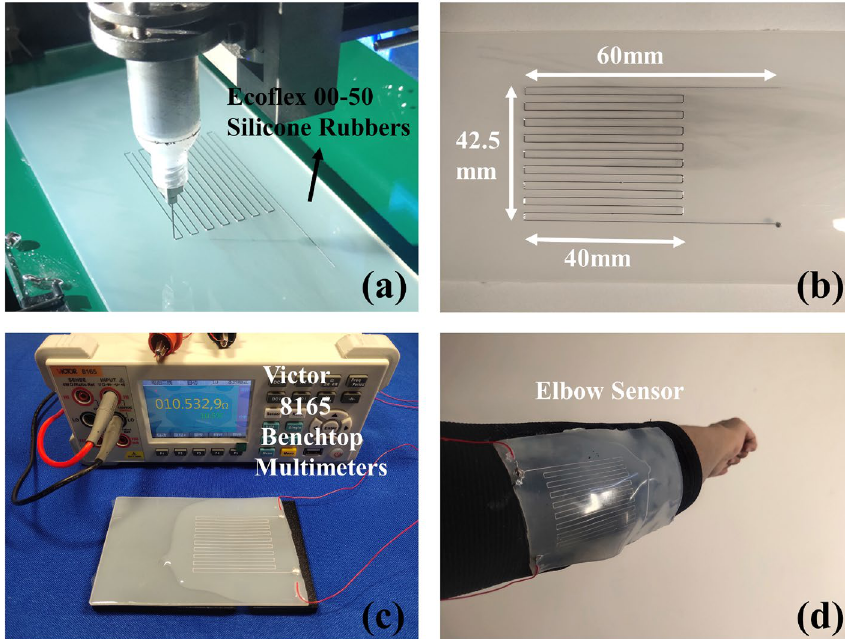
Figure 4. Micro-vibration printing application. ( a ) Printing process for sensor structure. ( b ) Size of the sensor structure. ( c ) Sensor conductivity display ( d ) Wearing of the elbow